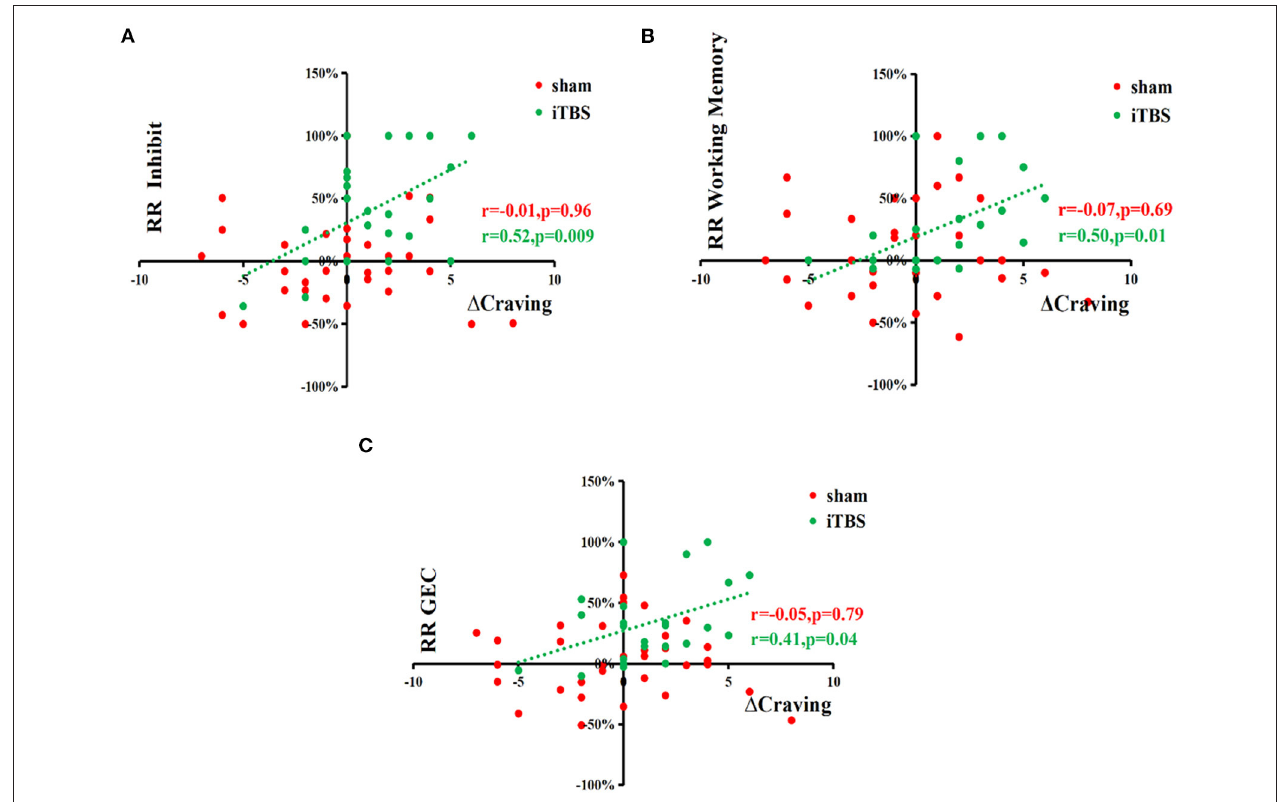
FIGURE 2 | Correlation analyses show the positive relationship between changes in craving ( 1 Craving) and reduced rates of subscale scores of inhibition, working memory, and GEC. Spearman rank correlation analysis between the changes of craving ( 1 Craving) and reduction rate of BRIEF-A, METH use history data, and demographics, respectively, in two MUD groups showed a significantly and positively relationship between 1 Craving and reduction rate of inhibition and reduction rate of working Memory in the iTBS groups ( N = 24). Other data showed no significant correlation. 1 Craving, changes of craving, RR, reduction rate.